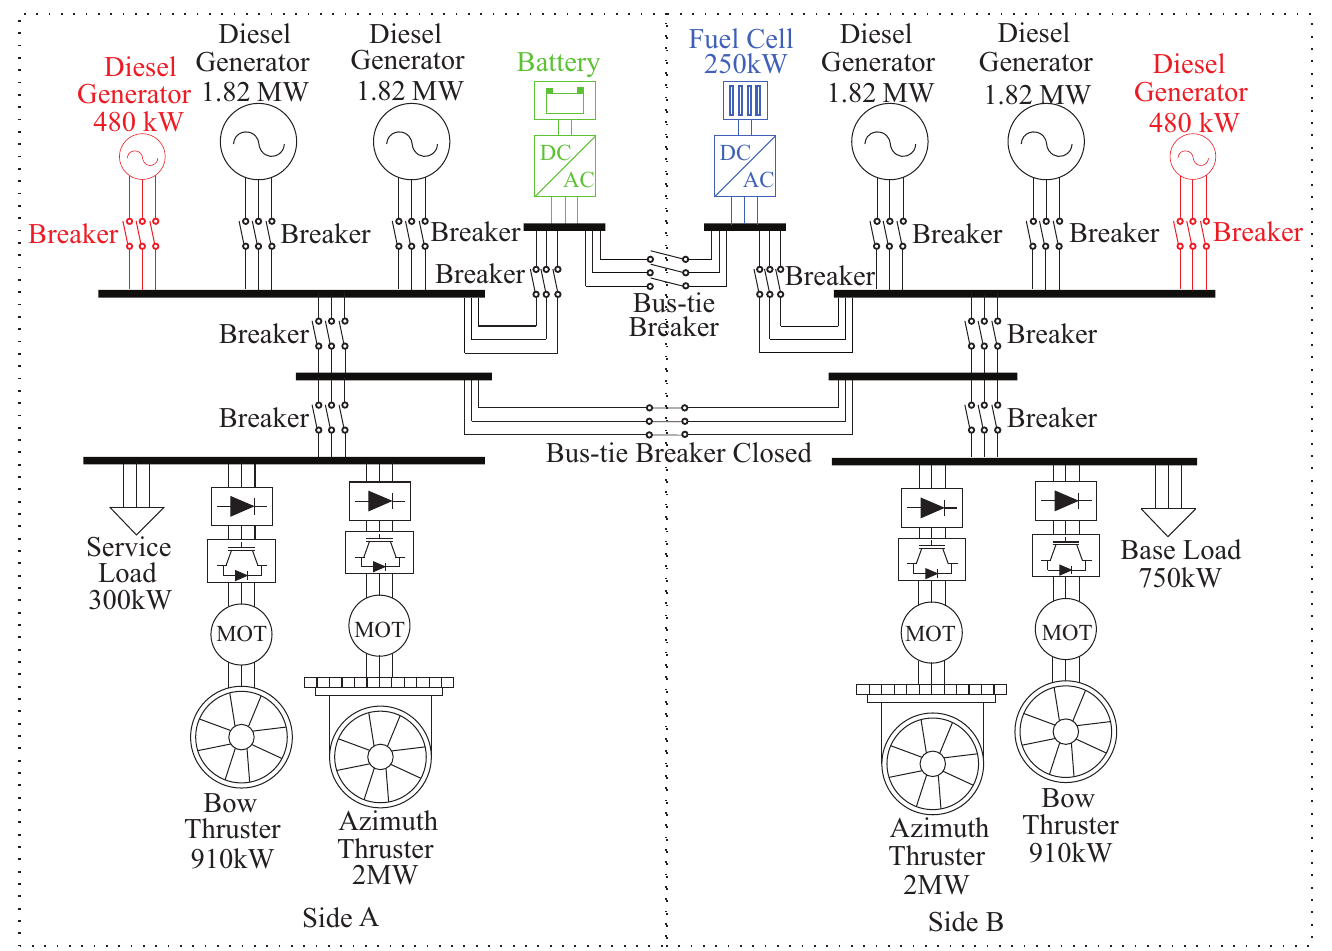
Figure 3. Schematic three-phase diagram of the PSV power